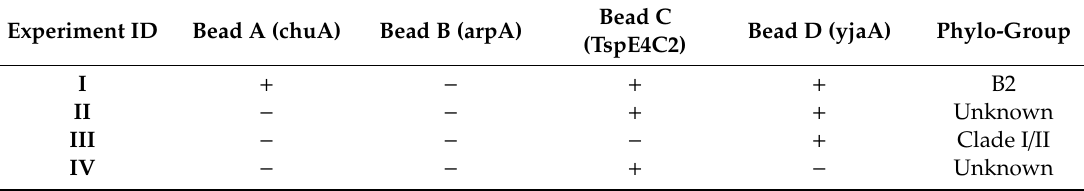
Table 2. Genotypes of isolated E. coli